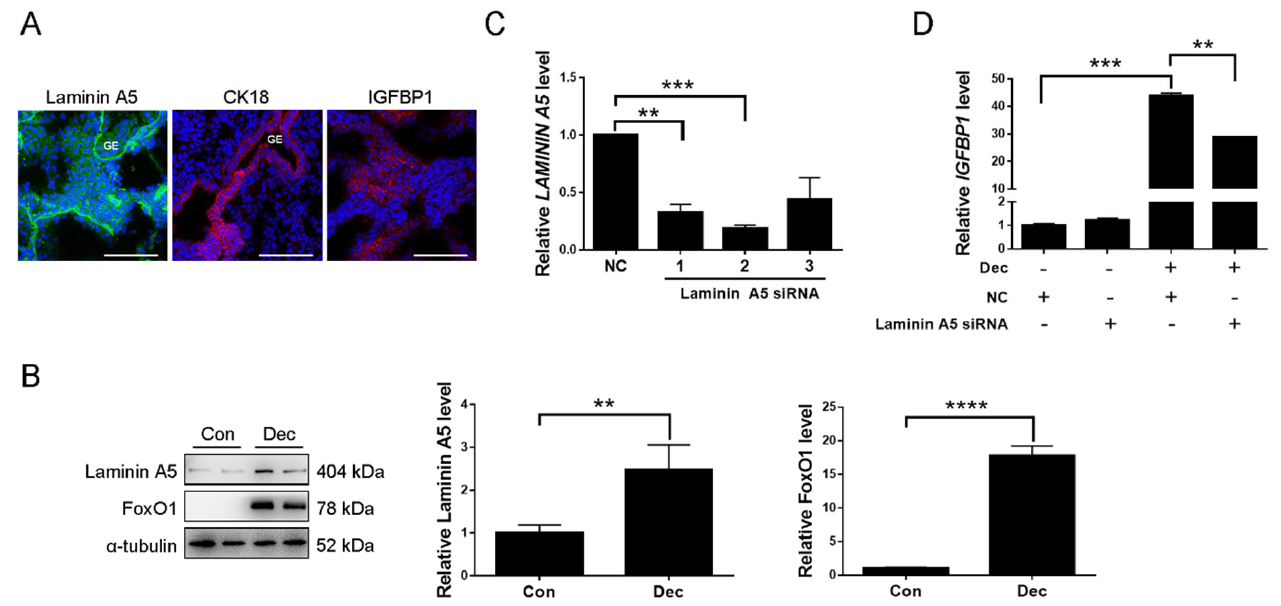
Figure 8. Expression and function of laminin A5 during human decidualization. ( A ) Immunofluorescence of laminin A5, CK18, and IGFBP1 expression in the human first-trimester decidua. GE, glandular epithelium. Scale bar = 100 µ m. ( B ) Western blot analysis of laminin A5 and FoxO1 protein levels after human stromal cells were induced for in vitro decidualized with MPA and db-cAMP for 6 days. ( C ) RT-qPCR analysis of LAMININ A5 mRNA level after human stromal cells were treated with LAMININ A5 siRNAs. ( D ) Effects of LAMININ A5 siRNA on IGFBP1 mRNA level under in vitro decidualization. Bars represent mean ± SD (** p -value < 0.01, *** p -value < 0.001, **** p -value < 0.0001). Dec, db-cAMP + MPA.